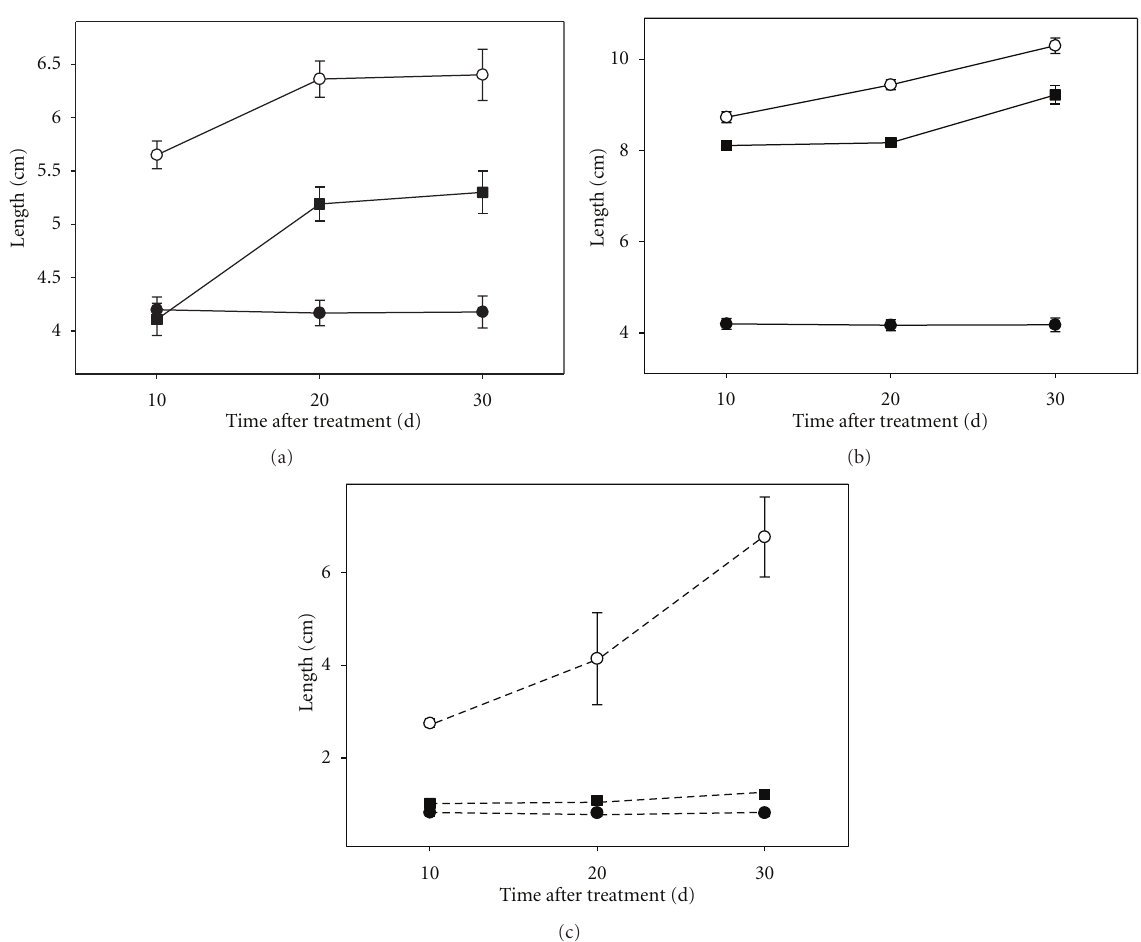
Figure 2: E ff ect of osmotic stress on organ length in Carrizo citrange cultured in vitro . (a): aerial part of intact plants; (b): root tissue of intact plants; (c): micropropagated shoots. Control plants (open circle), plants cultured under moderate (filled square) or severe (filled circle) osmotic stress